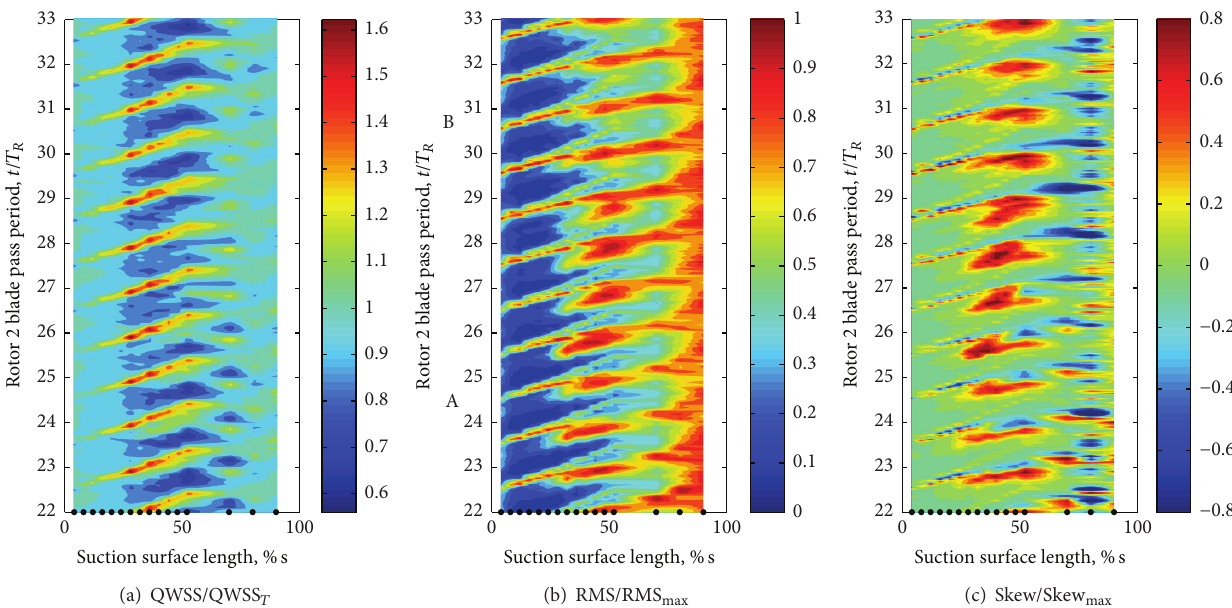
Figure 4: St-diagram of (a) QWSS, (b) RMS, and (c) skew for Stator 2 at peak efficiency